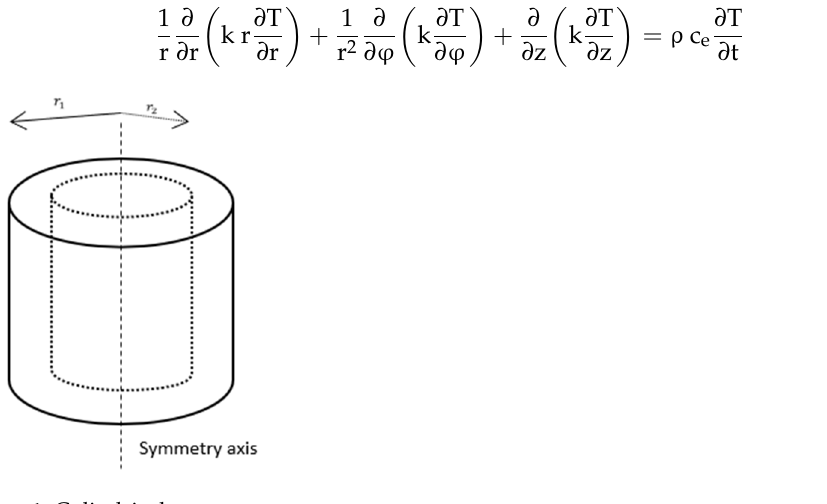
Figure 1. Cylindrical geometry.